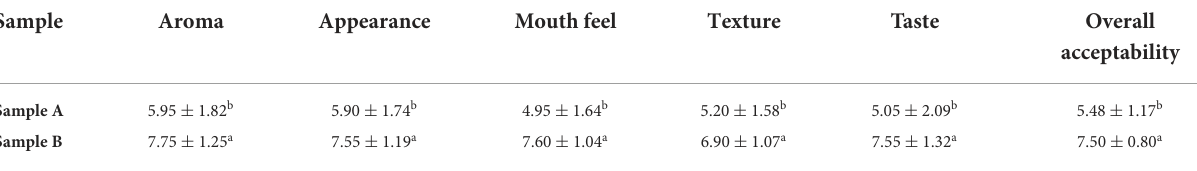
TABLE 2 Sensory attribute of